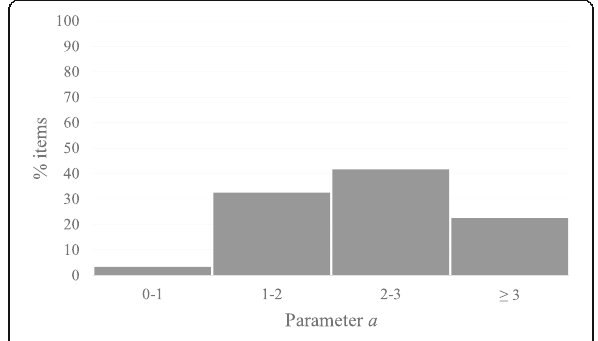
Fig. 1 Distribution of the parameter a values of the items